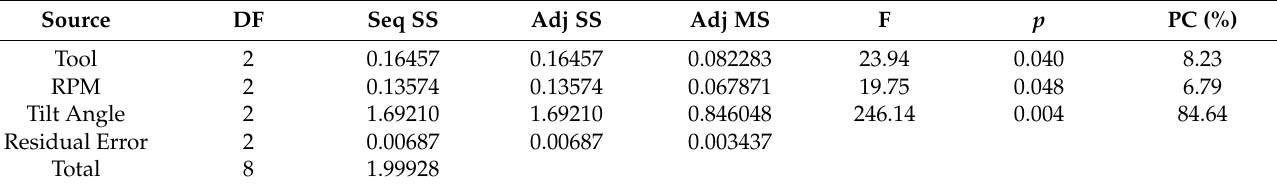
Table 8. Analysis of variance for SN ratios.